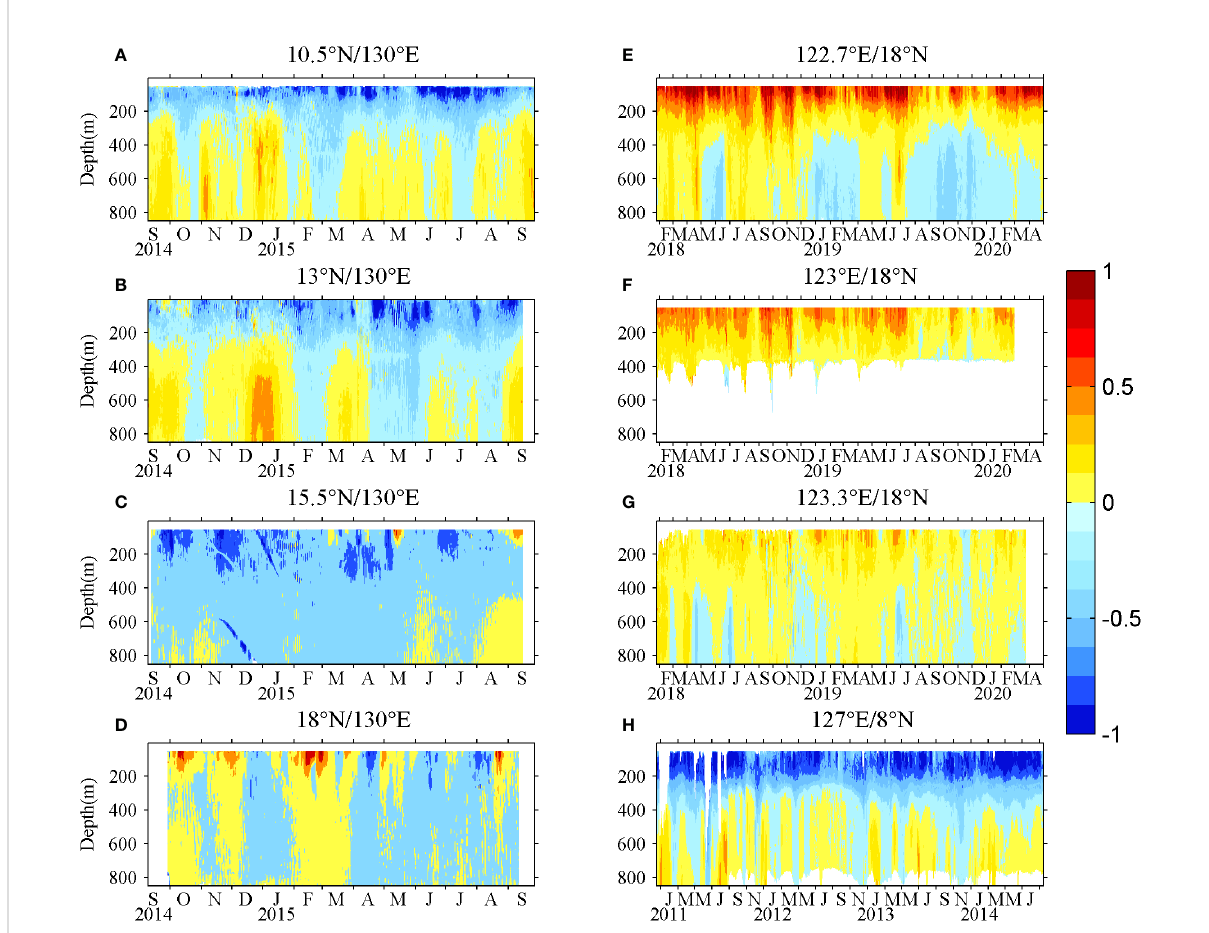
FIGURE 3 Zonal velocities derived from ADCPs at (A) 10.5°N, (B) 13°N, (C) 15.5°N, (D) 18°N along 130°E and meridional velocities derived from ADCPs at (E) 122.7°E, (F) 123°E, (G) 123.3°E along 18°N and (H) 127°E/8°N. (Units are